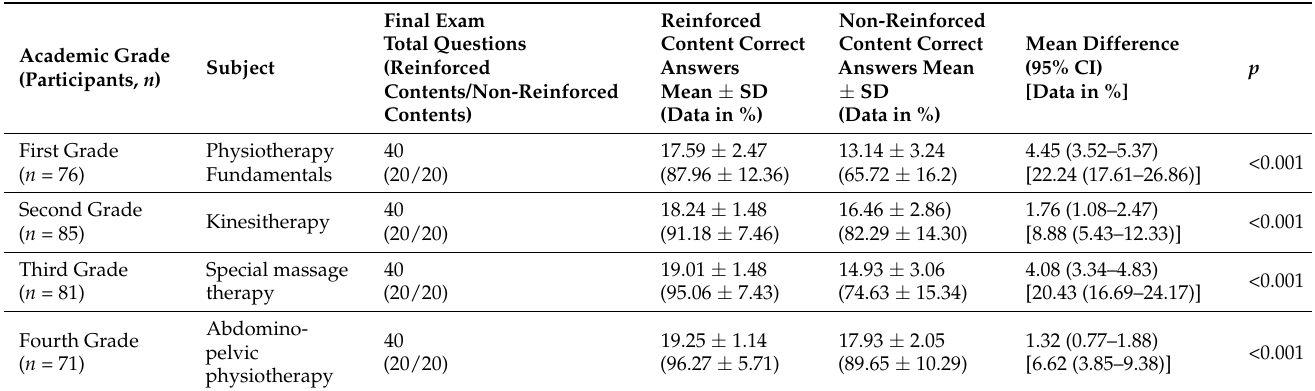
Table 3. Effectiveness of gamification in reinforcing content. Correct answers in the final exam of the subject: reinforced contents versus non-reinforced contents.